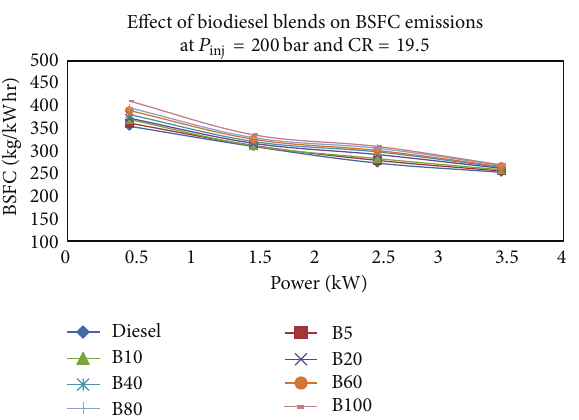
Figure 26: Variation in BTE for various biodiesel blends at 𝑃 inj 180 bar and CR 19.5.